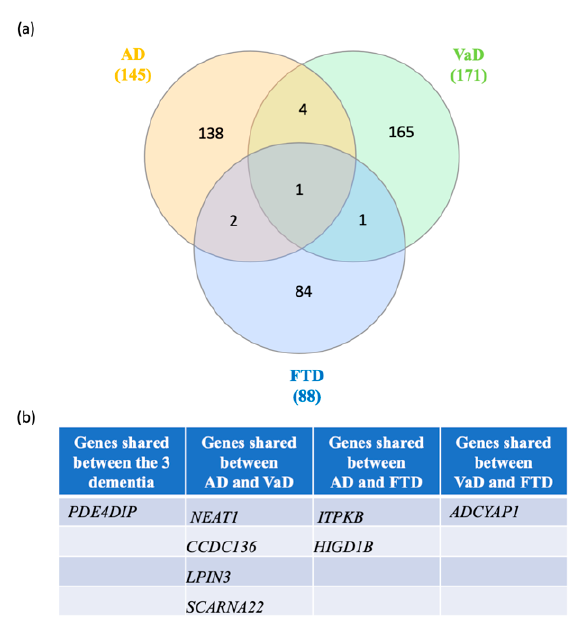
Figure 5. Venn diagram analysis of the switch genes shared in AD, VaD and FTD. ( a ) Venn analysis was performed using the following website: http://www.interactivenn.net/. ( b ) List of the switch genes shared between each dementia.